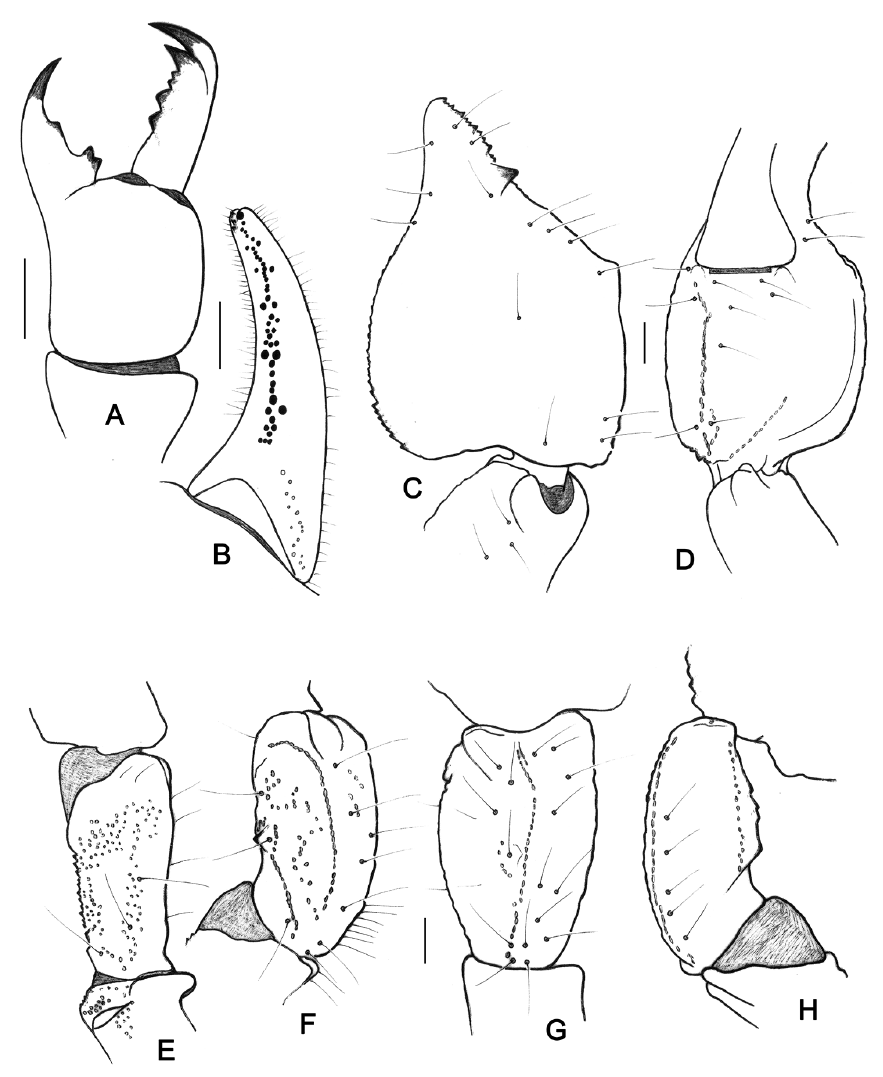
Figure 8. Teuthraustes kuryi sp. n. Female holotype. A Chelicera, dorsal aspect B Disposition of the granu- lation over the dentate margins of pedipalp-chela movable finger C–H Trichobothrial pattern C–D Chela, dorso-external and ventral aspects E Femur, dorsal aspect F–H Patella, dorsal F external G and ventral H aspects. Scale bars 1